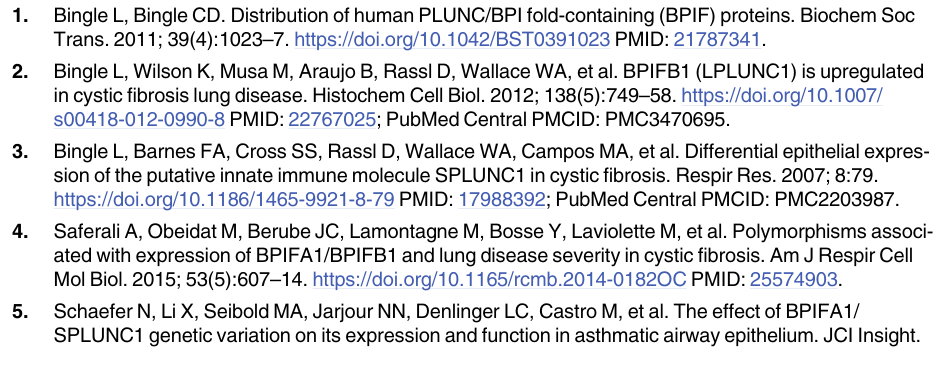
S1 Table. Differentially expressed genes after BPIFA1 or BPIFB1 treatment of IB31 cells.